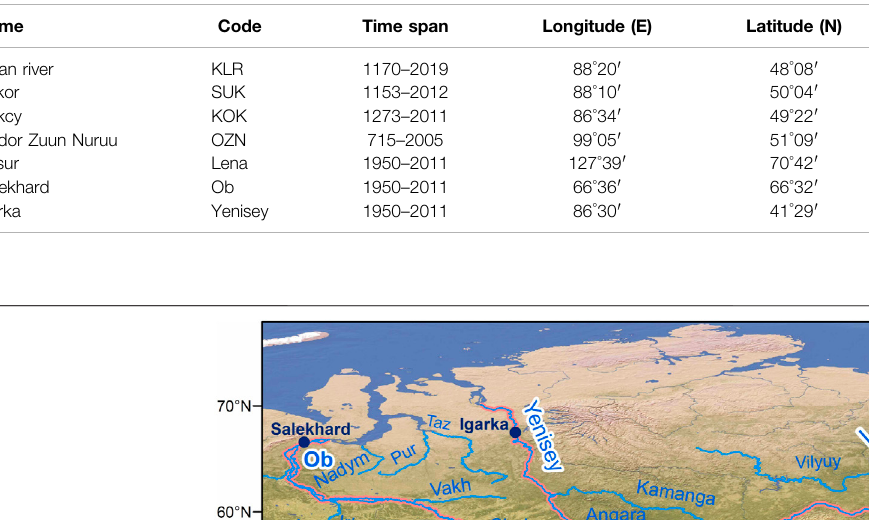
TABLE 1 | Information about the sampling sites, meteorological and gauge stations in the northern Mongolian Plateau.